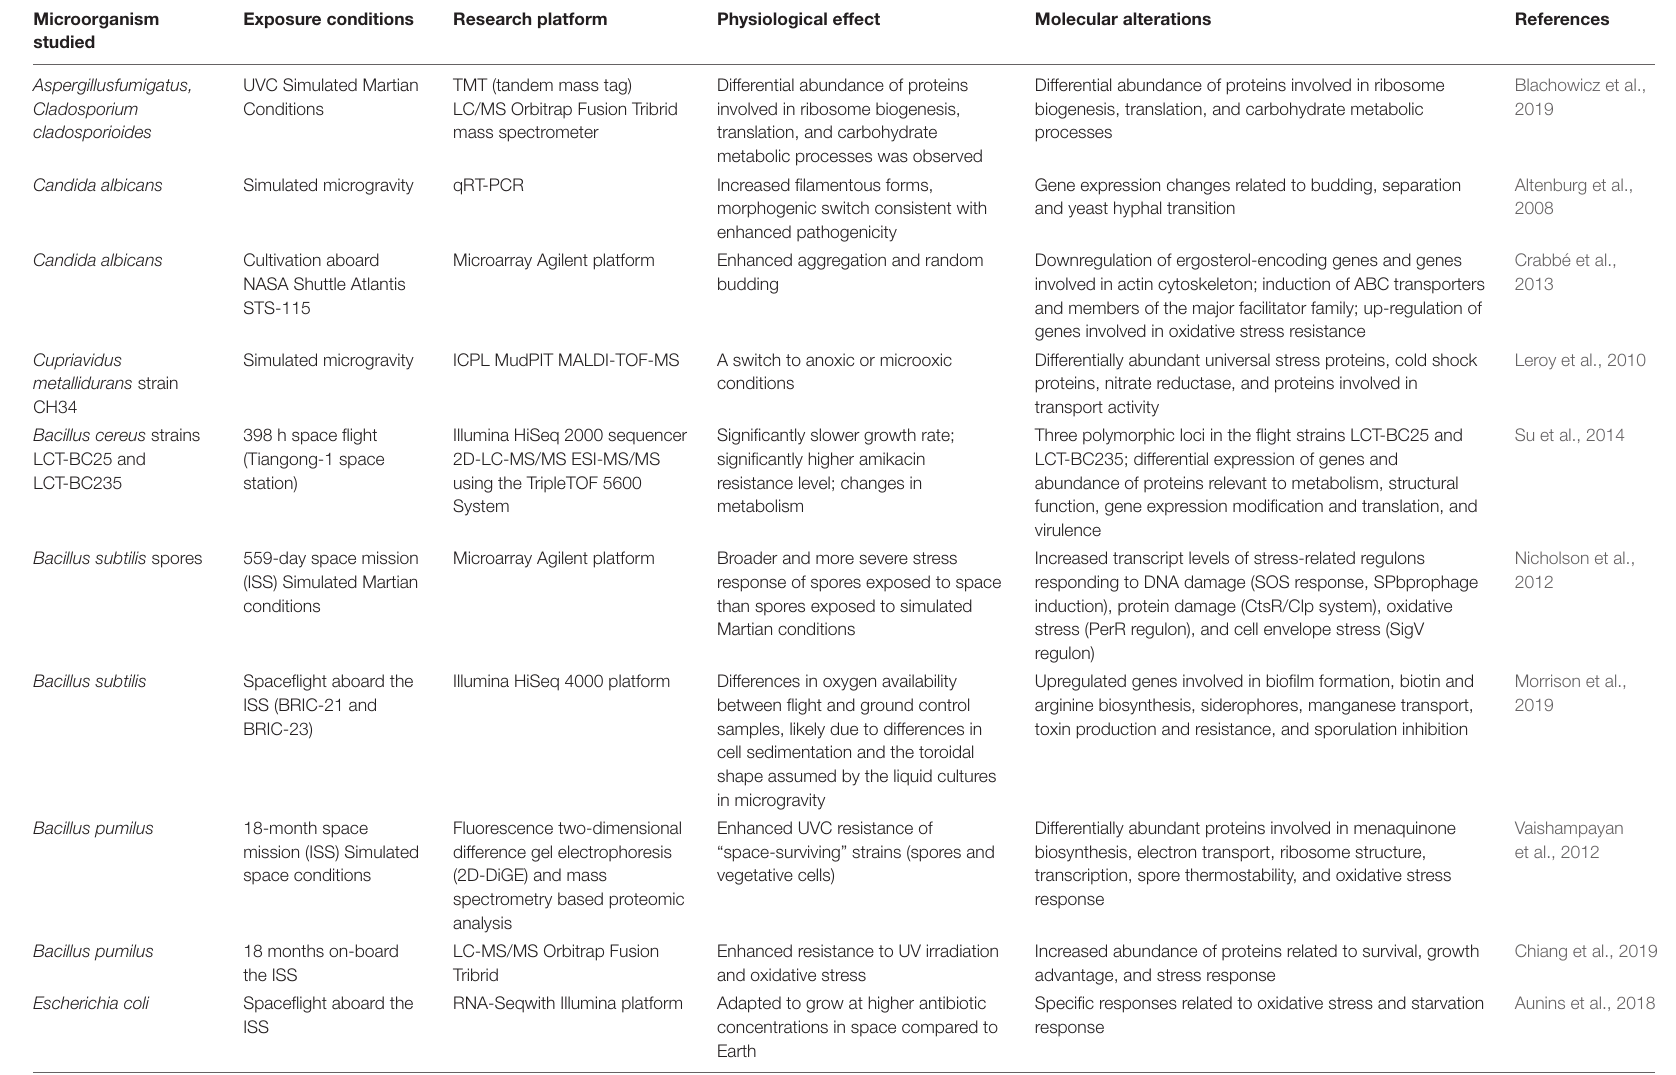
TABLE 1 | Omics studies of the microbial physiology in real and simulated outer space